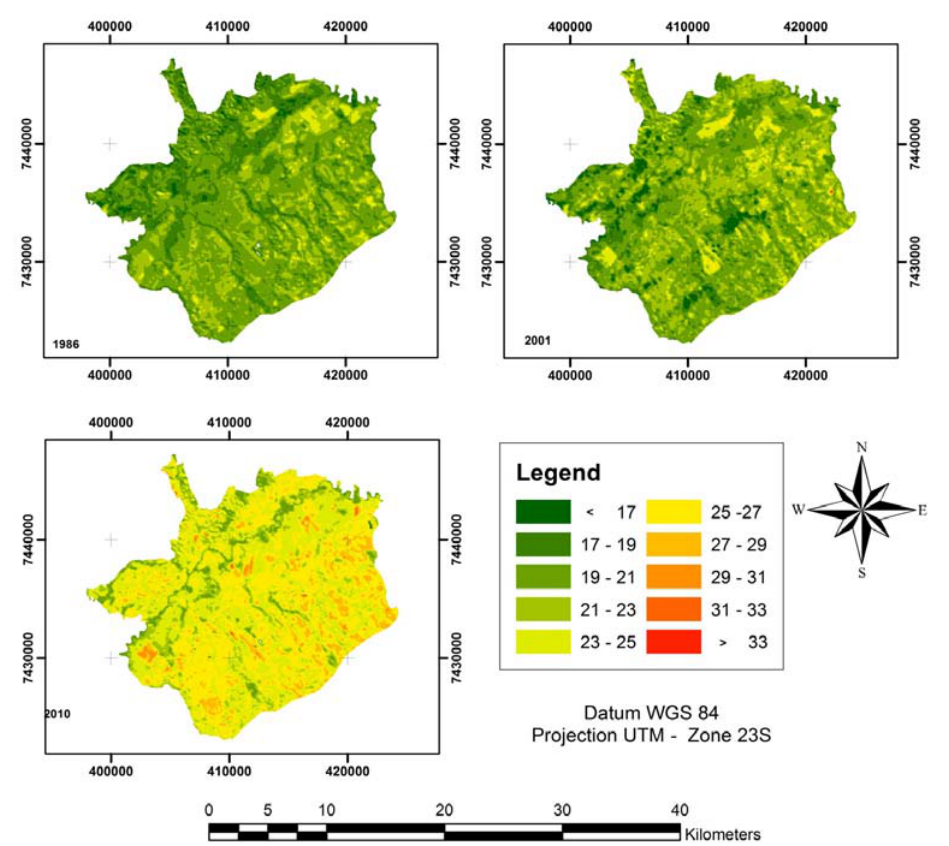
Figure 3. Land surface temperatures (LST) derived from the TIR band of TM/Landsat 5 image from 1986, 2001 and